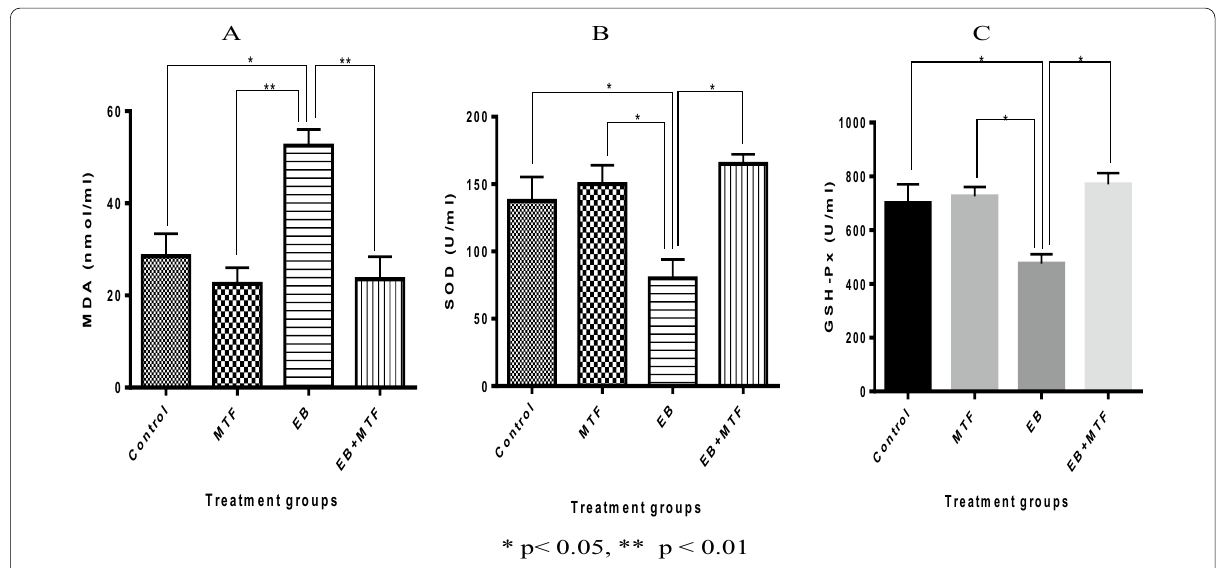
Fig. 3 Effect of oral administration of metformin on MDA level ( a ), SOD ( b ) and GSH ( c ) activities in normal and EB-treated female rats